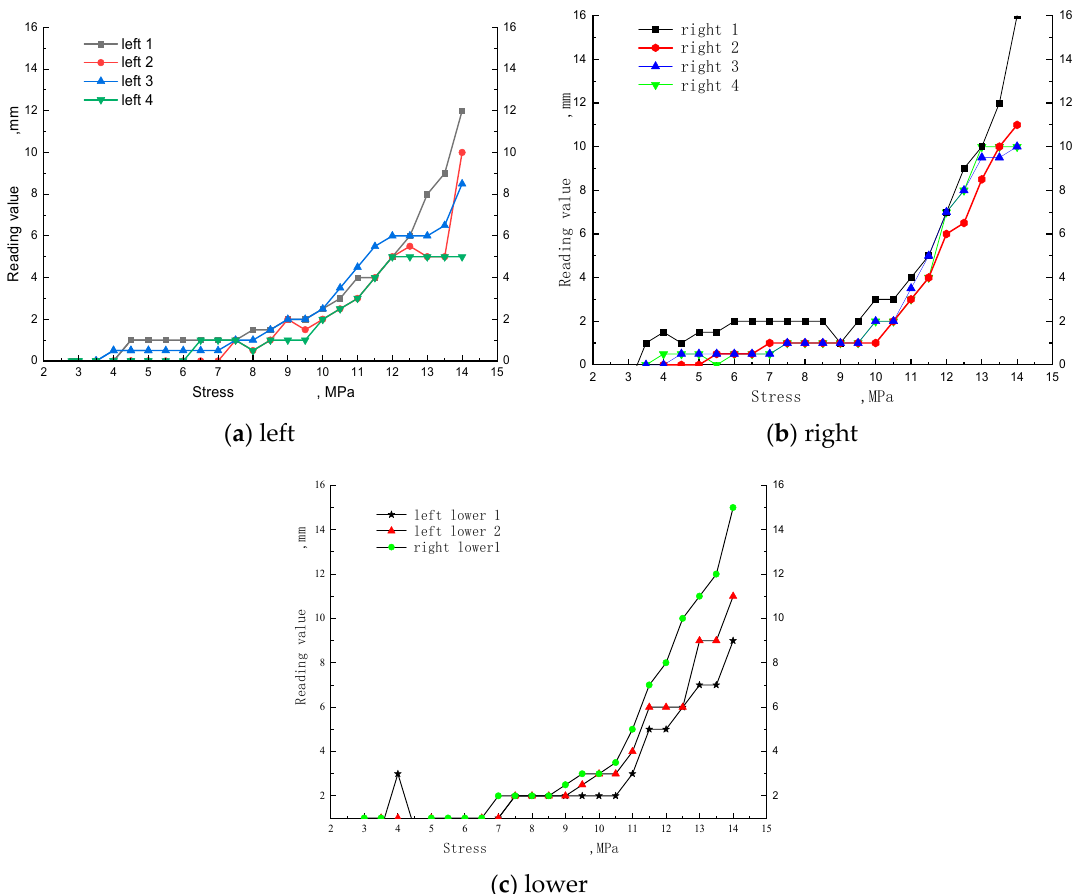
Figure 6. Left, right, lower left, and lower right multipoint displacement meter readings.